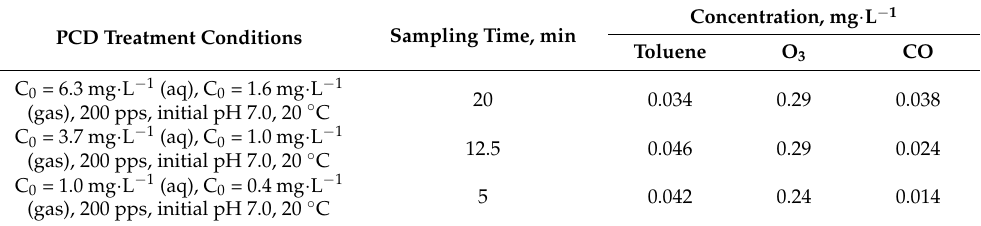
Table 3. Contents of toluene, ozone, and carbon monoxide in PCD outlet gas entering photocatalytic